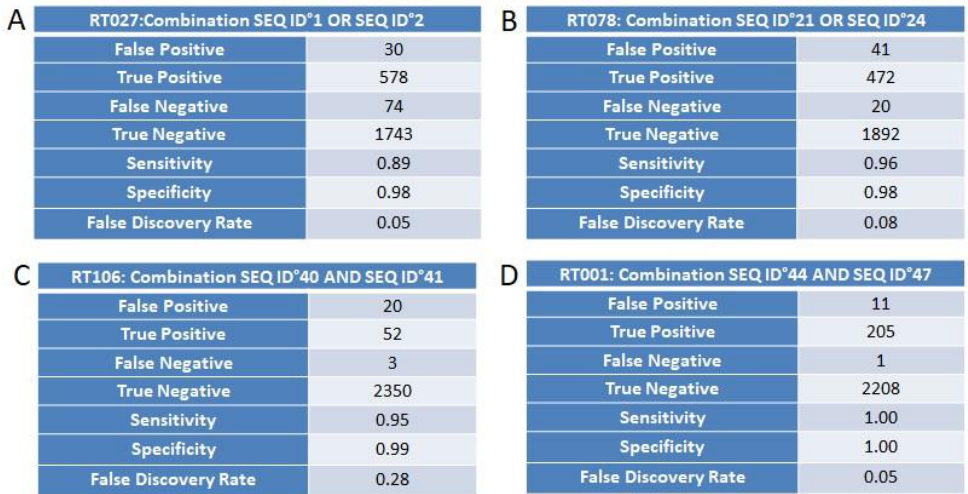
Figure 3. Statistical comparison of genome typing efficiency of discovered unique patterns for selected C. difficile ribotypes in terms of specificity, sensitivity, and false discovery rate (FDR).